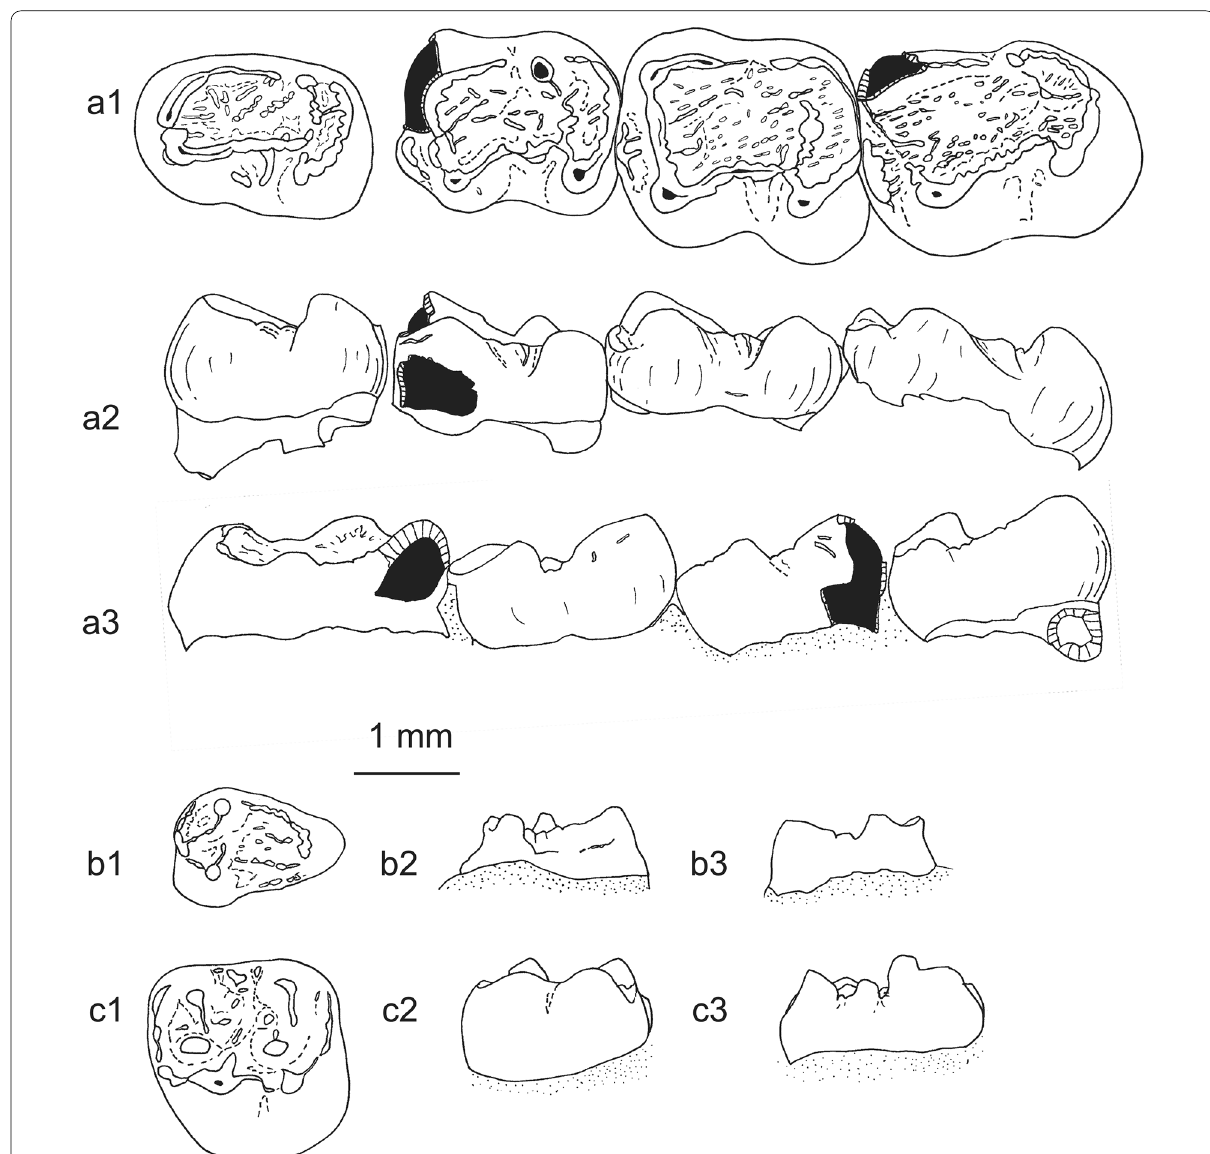
buccal aspect; a3, lingual aspect. b Ek 79, right dp4, base of the crown embedded in the gangue; b1, occlusal view; b2, buccal aspect; b3, lingual aspect. c : Ek 85, left M1, weakly worn; c1, occlusal view; c2: lingual asect; c3: buccal aspect. Scale bar